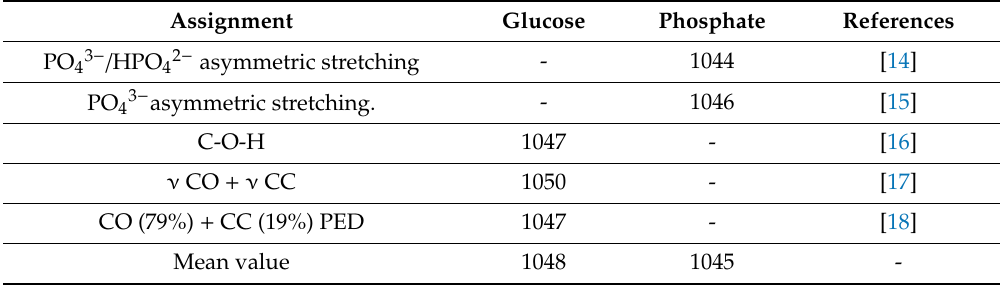
Table 5. IR data (cm − 1 ) for glucose C(6)O-H and solid-state phosphates [4]. The quoted assignments are from respective authors.